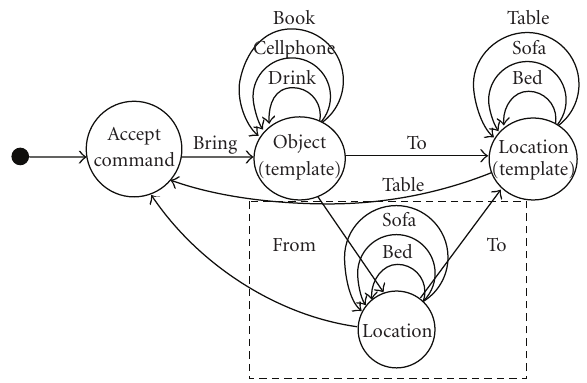
Figure 11: An example of three automaton unification. Dotted rectangle part is the extended part from the example shown in Figure